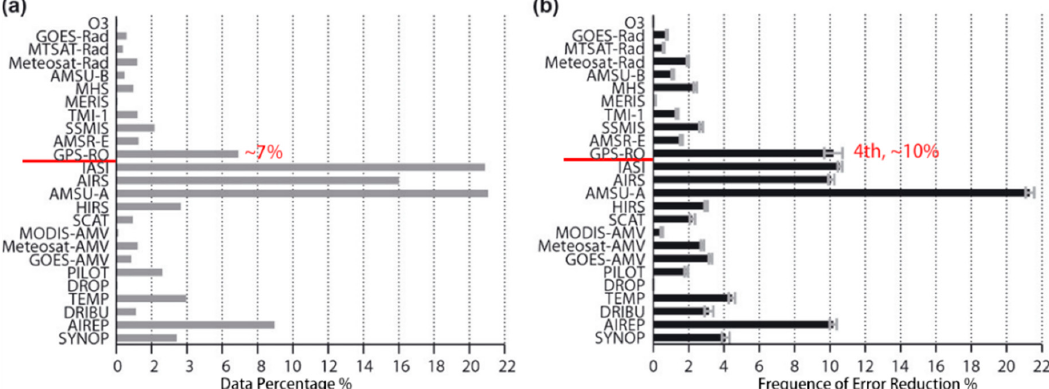
Figure 6. Evaluation of various observations assimilated by the ECMWF. ( a ) Data Percentage; ( b ) Frequency of Error Reduction. While accounting for only 7% of the total observations in the assimilation system, RO has the fourth-largest impact on NWP. Adapted from [44].